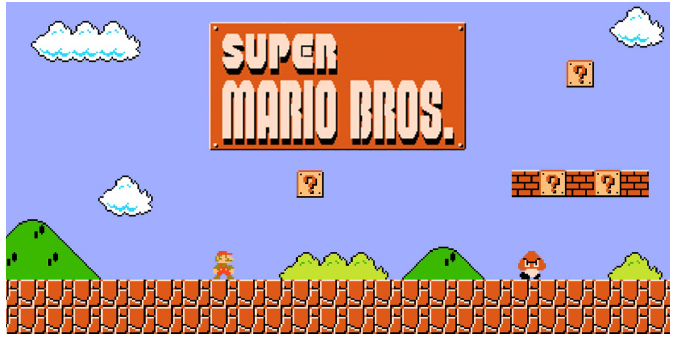
Figure 1. Start of the first level of Super Mario Bros game. There are virtually infinite possible decisions, in the form of movement sequences. Players can press up to 60 combinations of inputs per second.